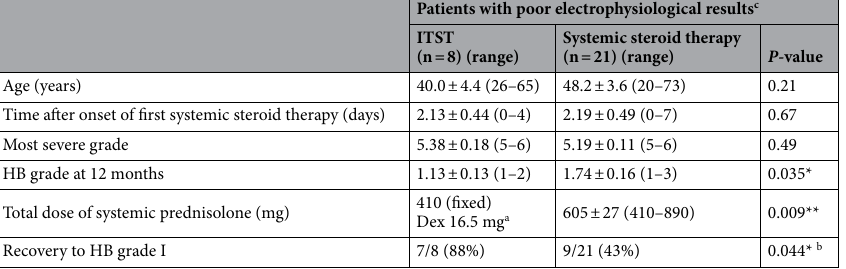
Table 2. Baseline characteristics and outcomes in patients with Bell’s palsy. Dex, dexamethasone; HB, House- Brackmann; ITST, intratympanic steroid therapy. * P < 0.05; ** P < 0.01. a Equivalent dosage is postulated to be 492.5 mg (see “Discussion” section). b Fisher’s exact test. c Based on electrophysiological test results of ≤ 10% on electroneurography.